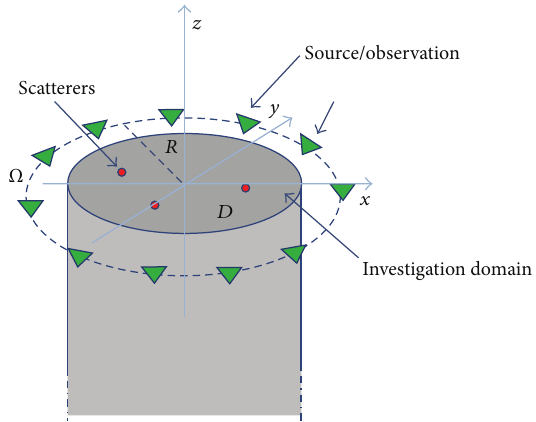
Figure 1: Measurement